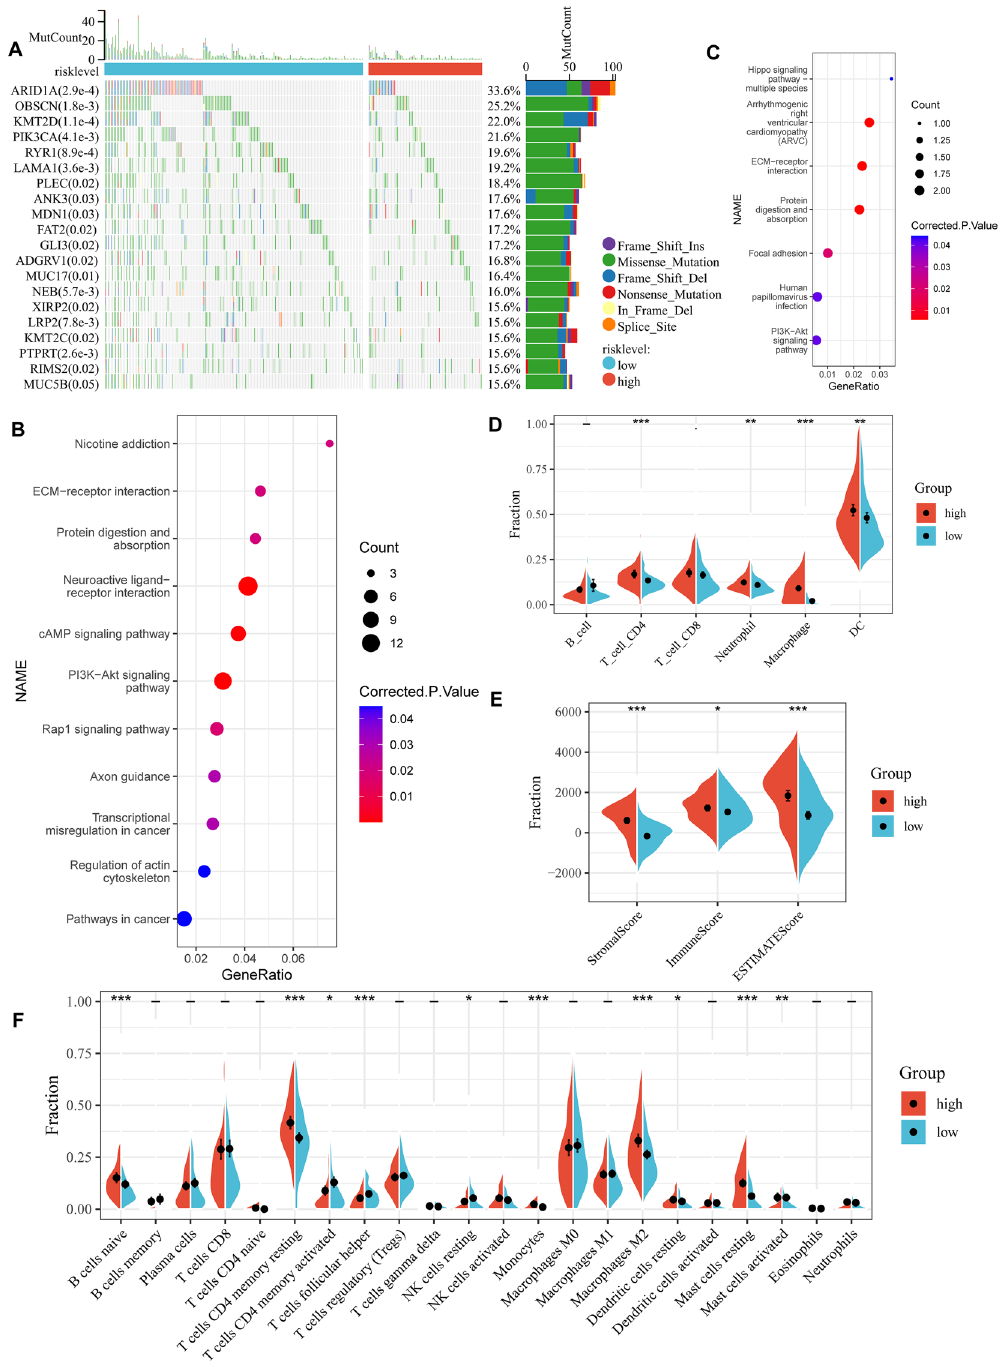
Figure 4. Differences between high- and low-risk groups. ( A ) Top 20 differentially mutated genes between two risk subgroups in all gastric cancer patients of TCGA-STAD cohort. ( B ) KEGG signaling pathway enriched for genes with low methylation and high expression in high-risk group. ( C ) KEGG signaling pathway enriched for shared genes between low methylation and high expression in high-risk group and turquoise module genes. ( D ) Relative proportion of 6 infiltrating immune cells estimated by TIMER between two risk subgroups of TCGA- STAD cohort. ( E ) Stromal score, Immune score and ESTIMATE score between two risk subgroups of TCGA- STAD cohort. ( F ) Relative proportion of 22 infiltrating immune cells estimated by CIBERSORT between two risk subgroups of TCGA-STAD